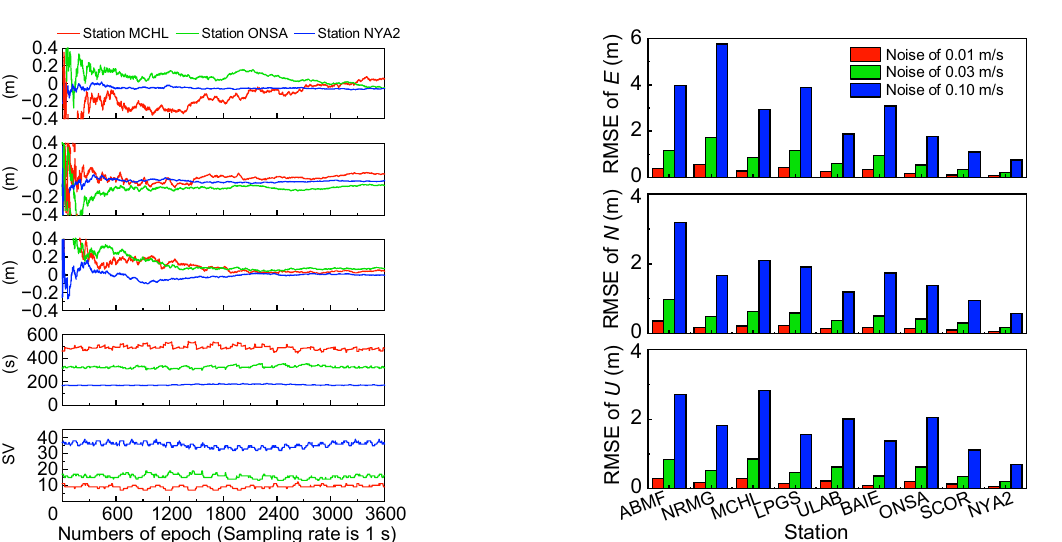
Fig. 9 Static Doppler positioning solutions in east (E), north (N), and up (U) directions at station MCHL, ONSA, and NYA2. The corresponding PDOP values and numbers of LEO satellites vehicle (SV) are also shown